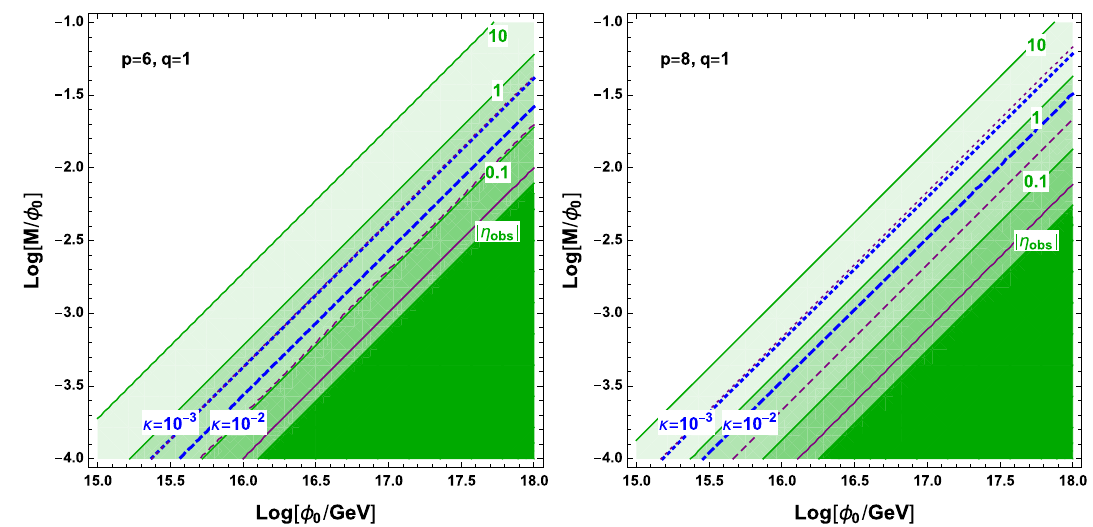
Fig. 2 Parameter spaces (blue dashed and dotted lines corresponding to κ = 10 − 2 , 10 − 3 , respectively) matching observations for the cases ( p , q ) = ( 6 , 1 ) (left) and ( p , q ) = ( 8 , 1 ) (right). In both panels, for the decay rate of ψ we used γ ψ = 1 (see Eq. (55)). Green regions cover ranges of g ( M ,φ 0 ) indicated by the number on the green diag- onal lines bounding the regions with different transparency leves. The